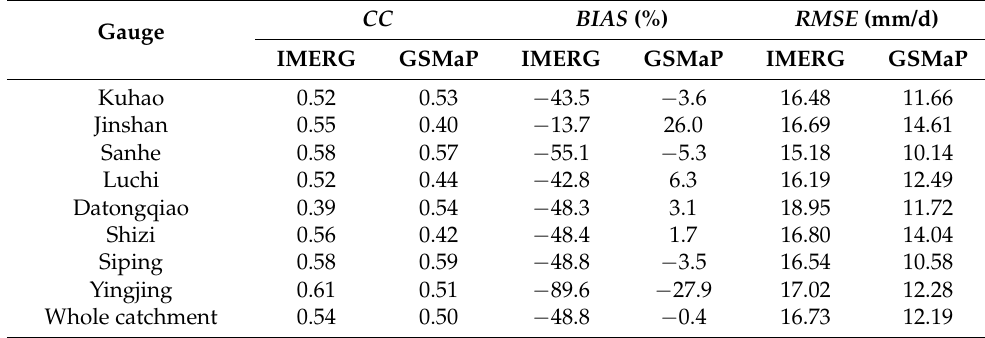
Figure 3. Spatial distribution of average daily rainfall over the study area from 2014–2018: ( a ) Rain gauge observations, ( b ) IMERG, ( c ) GSMaP. Table 4. Summary of evaluation of IMERG and GSMaP products at daily